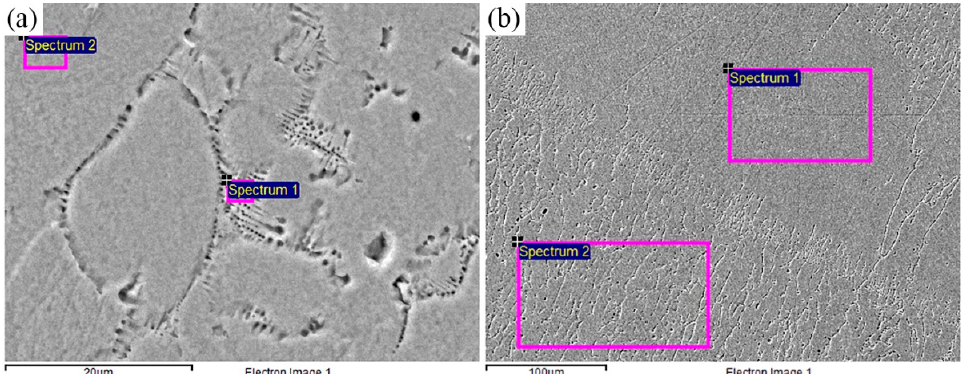
Figure 6. EDS characterization of ( a ) equiaxed grains; ( b ) fusion lines and layers.